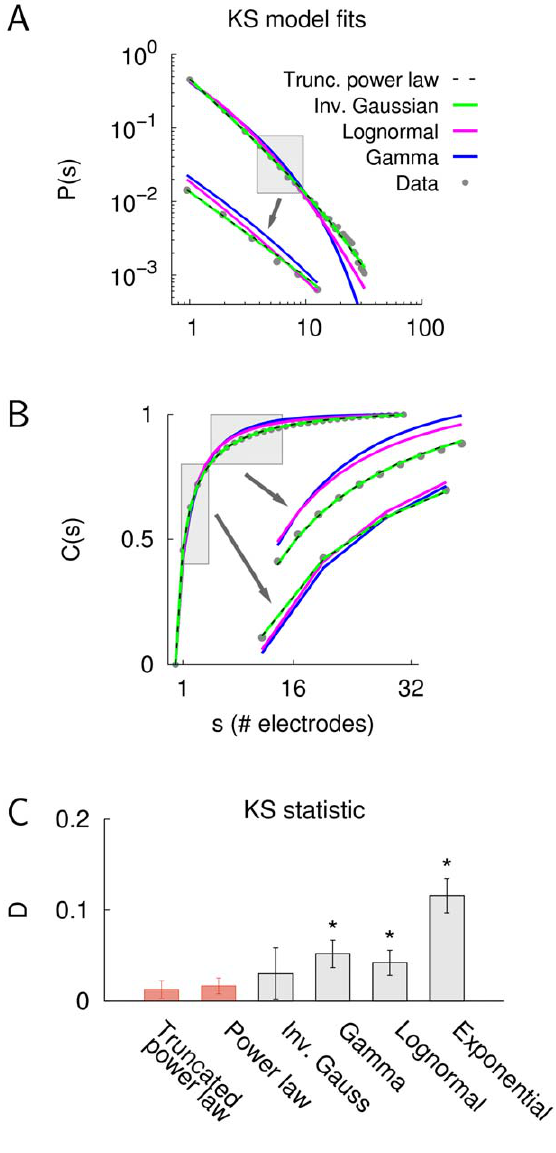
Figure 5. Model comparison based on the KS statistic. A. PMFs of the two-parameter models for the avalanche size distribution in monkey X. The inset shows a detailed view that corresponds to the gray rectangle. B. Corresponding CDF fits for the same size distribution (i.e., monkey X). The insets show detailed views of the distributions, corresponding to the respective gray rectangles. C. Average KS distance of the model distributions for all data sets ( n =16, which includes 7 data sets recorded in vitro, 7 in vivo under anesthesia, and 2 in vivo awake). Error bars denote the standard deviation. The single-parameter power law and the power law with exponential cut-off yielded significantly better fits to the data than the gamma, the lognormal, or the exponential distribution (Kruskal-Wallis test and Tukey-Kramer multiple comparison, p , 0.0001).